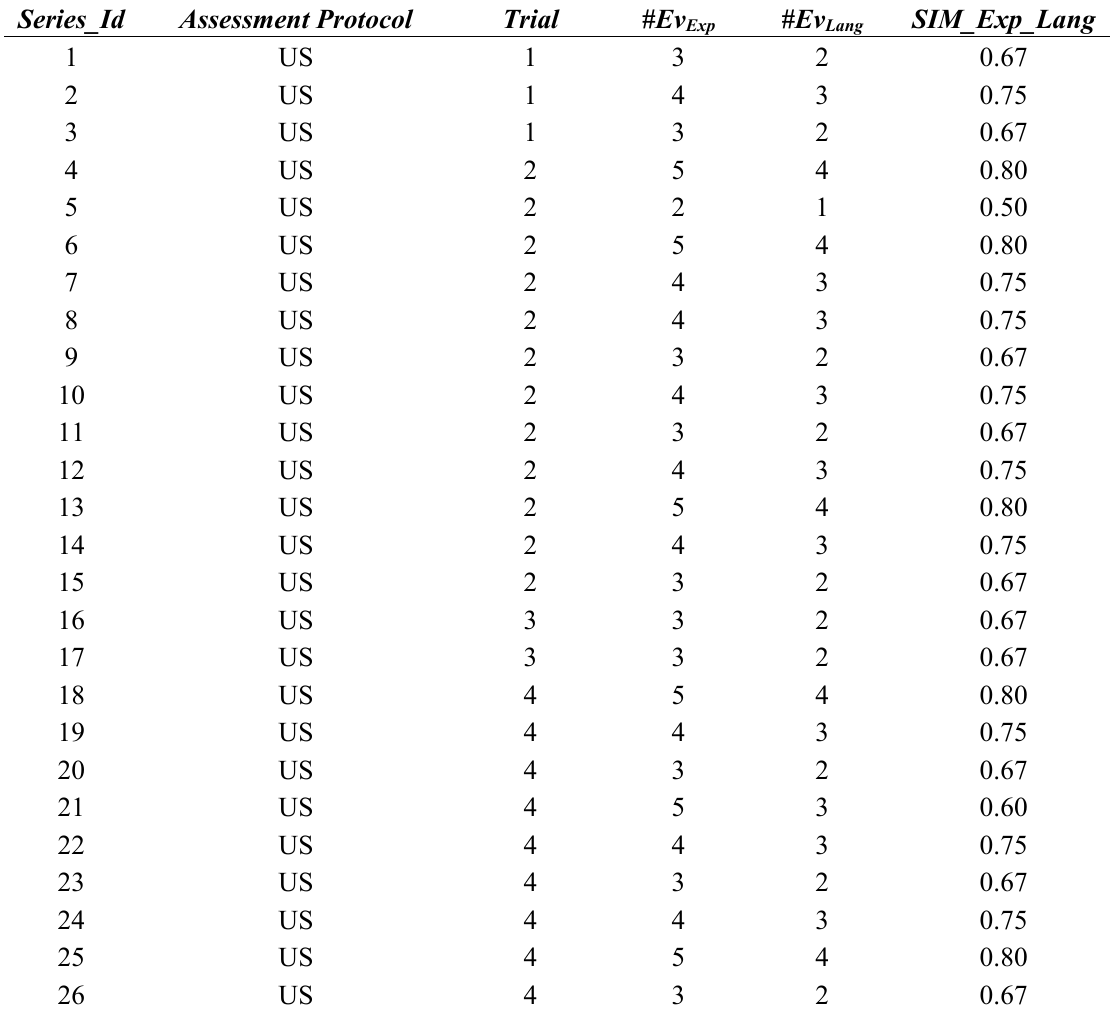
Table 10. Detailed results of the 60 least similar stabilometric time